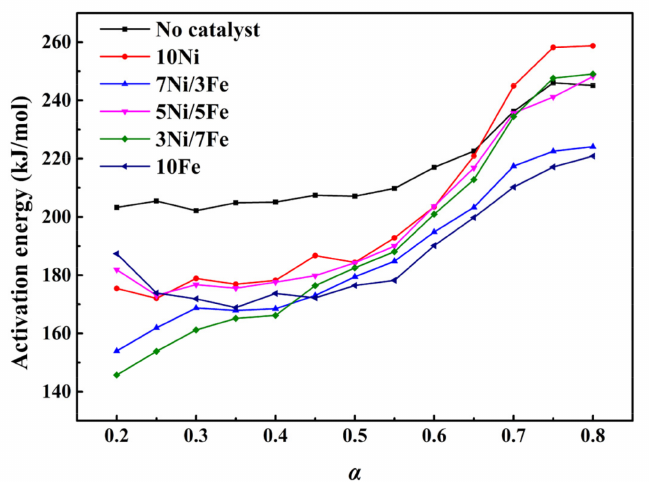
Figure 3. Activation energy distributions of WT catalytic pyrolysis with no catalysts and different synthesized catalysts. Table 3. Activation energies of all samples with Starink’s method.